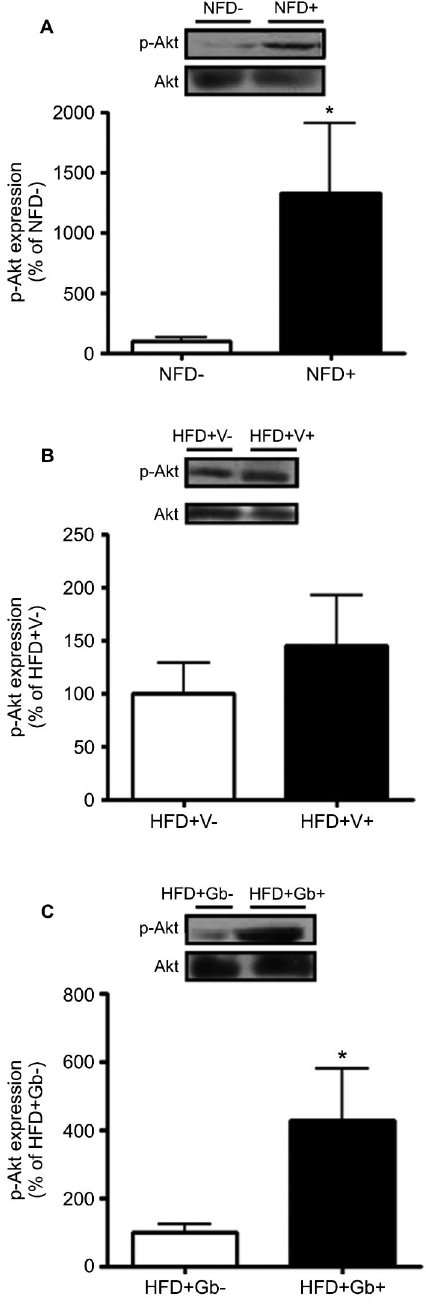
Figure 6. Akt phosphorylation levels in gastrocnemius muscle of A , NFD–– (basal, n=5) and NFD++ (insulin-stimulated, n=5); B , HFD++V–– (basal, n=6) and HFD++V++ (insulin-stimulated, n=6); and C , HFD++Gb–– (basal, n=6) and HFD++Gb++ (insulin- stimulated, n=6) groups after phytotherapy treatment. Akt: protein kinase B; NFD: normal fat diet; HFD: high-fat diet; V: vehicle (saline); Gb: Ginkgo biloba . *P , 0.05 vs basal (Student t -test).